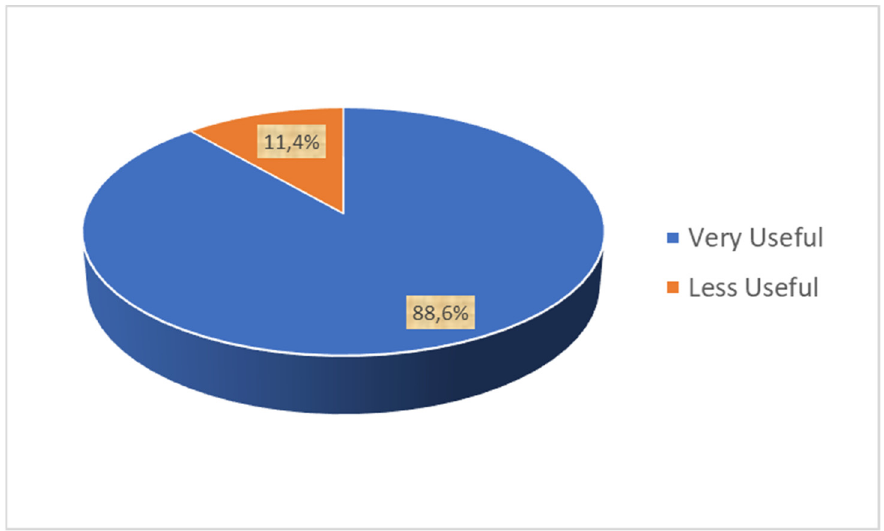
Figure 6. Rating of blended learning based semester credit system implementation model.